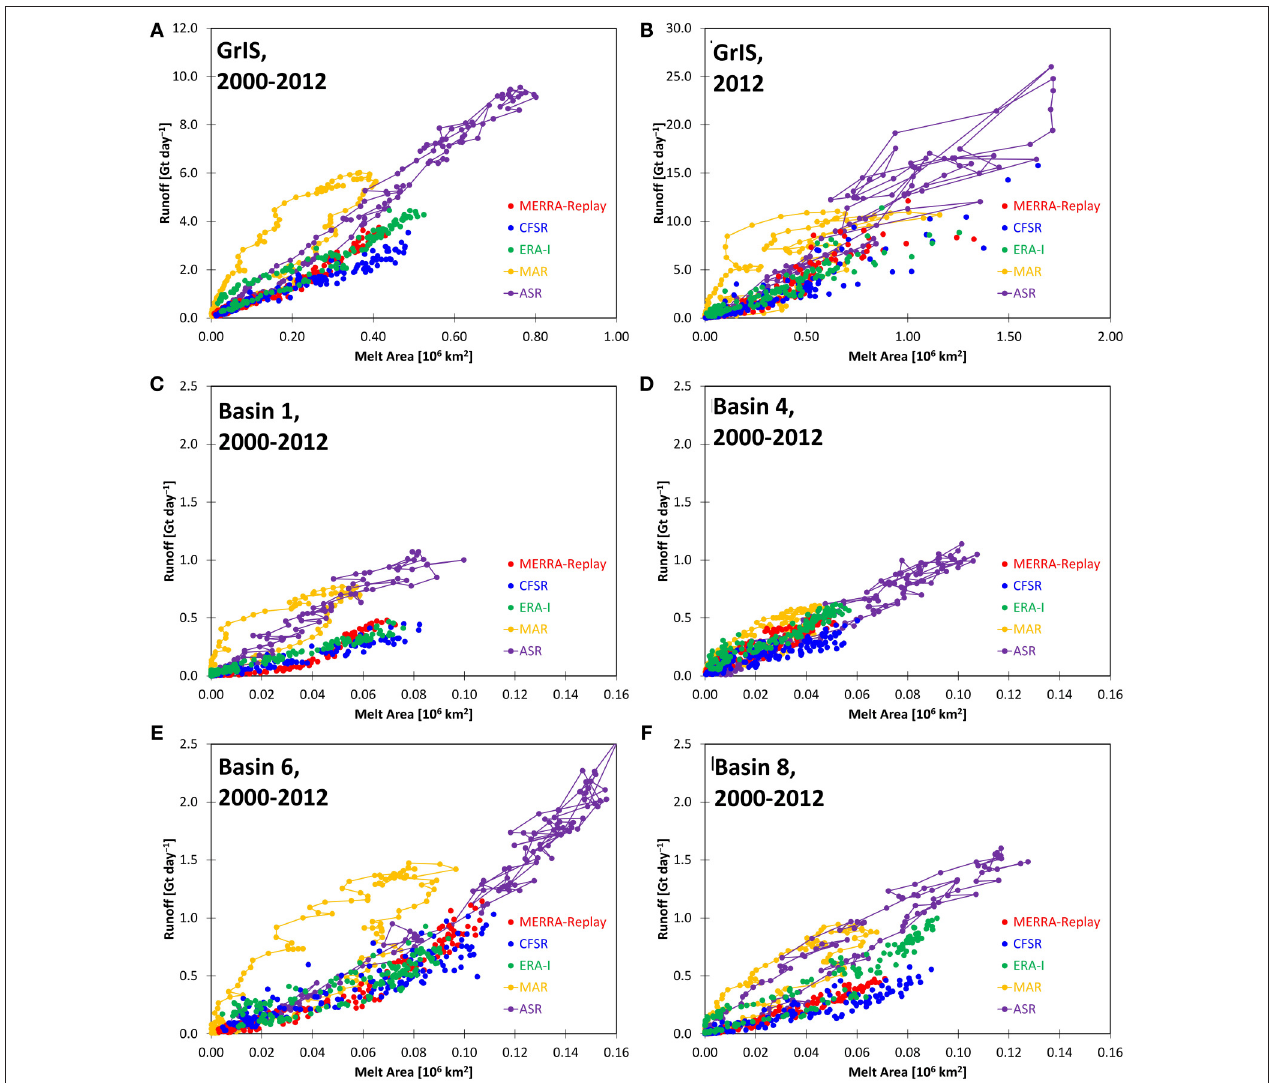
FIGURE 10 | Daily runoff in Gt day − 1 vs. melt area in 10 6 km 2 from five data sets for (A) the total GrIS, averaged for 2000-2012; (B) the total GrIS for the year 2012; and (C) drainage basin 1, (D) basin 4, (E) basin 6, and (F) basin 8 averaged for 2000-2012, in Gt day − 1 . Connecting lines for MAR and ASR values indicate the progression of the seasonal